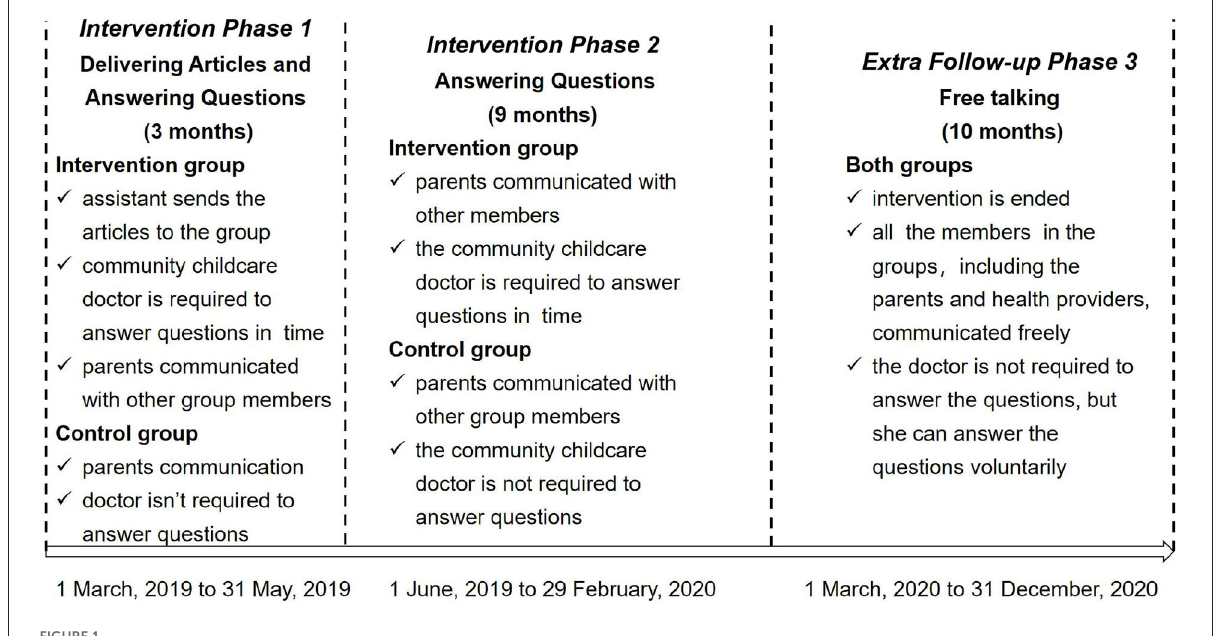
FIGURE1 The phases of study